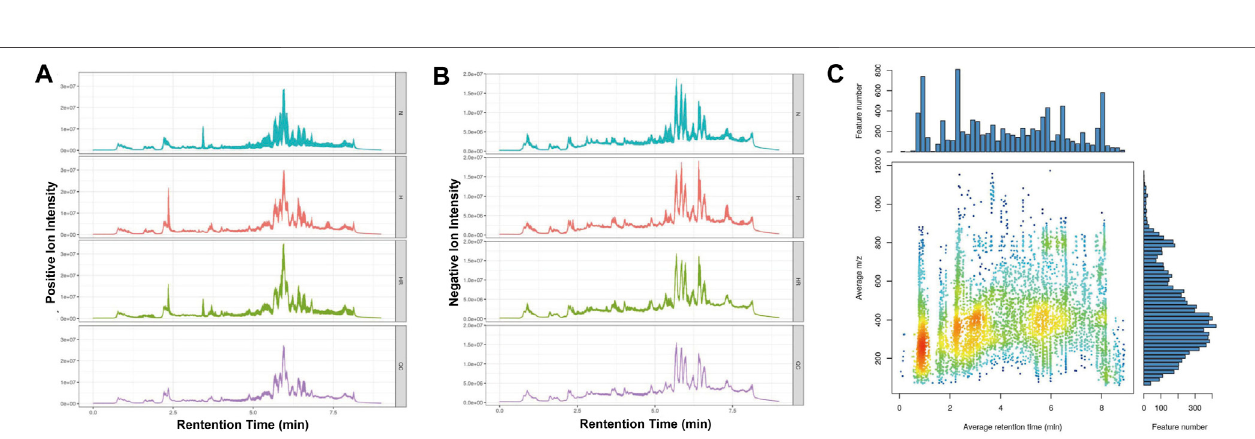
FIGURE 3 | Quality control of metabolomics detection. (A) The total ion chromatogram (TIC) of all liver samples in the positive model. (B) Total ion chromatogram (TIC) of all liver samples in negative model. (C) The m/z – rt distribution. Normal (N); high-fat diet (H); and high-fat diet plus resveratrol (HR).